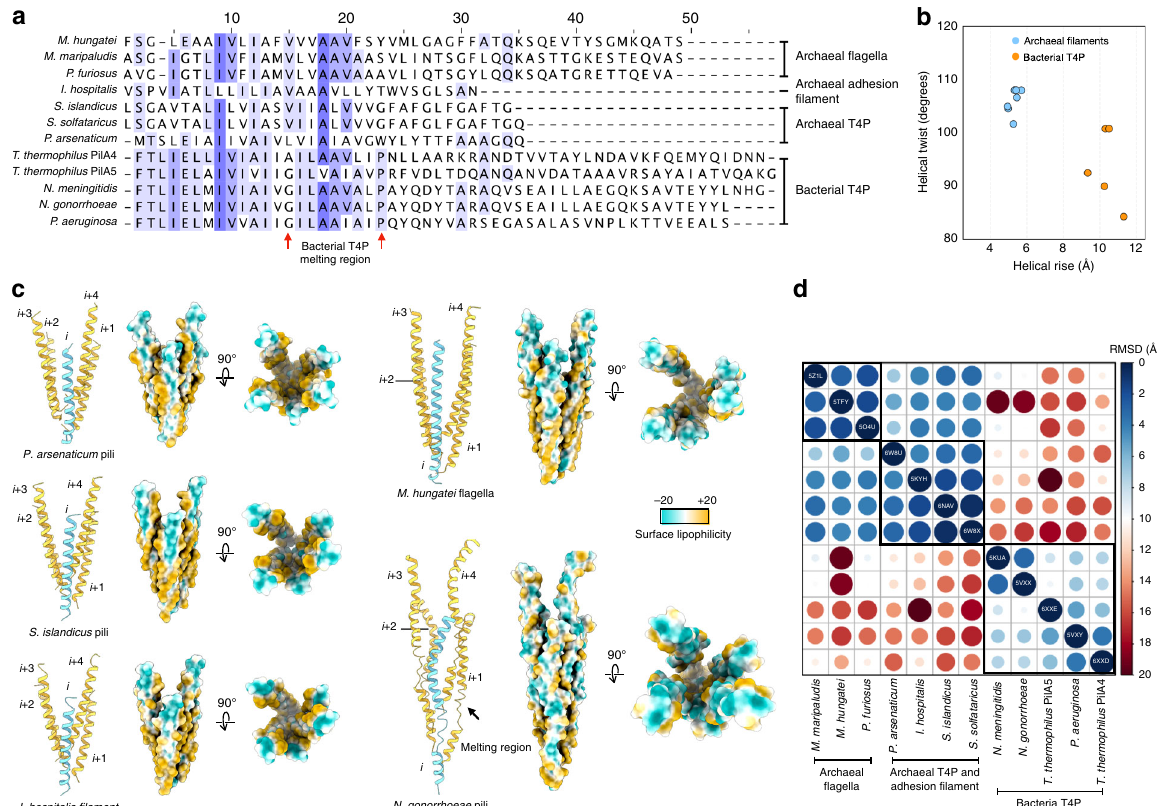
Fig. 4 Conservation and divergence of the N-terminal helical bundles. a Sequence alignments of the N-terminal long helix in three archaeal fl agellins, one archaeal “ adhesion ” protein, three archaeal T4P and three bacterial T4P. Area where the bacterial T4P N-terminal helix melts is indicated by two red arrows. b Helical symmetries of the fi laments mentioned in a , with archaeal fi laments light blue and bacterial fi laments orange. c Five adjacent N-terminal helices of P. arsenaticum pilins, S. solfataricus pilins, I. hospitalis proteins, M. hungatei fl agellins and N. gonorrhoeae pilins are shown. The C α trace is shown in cartoon (left), with one helix colored cyan and the other four colored yellow. The bundles are also shown in an atomic surface view and colored by lipophilicity (right). d All-against-all comparison of the fi ve helix bundles of the structures shown in a . The matrix is based on the pairwise RMSD comparisons calculated from PyMOL.